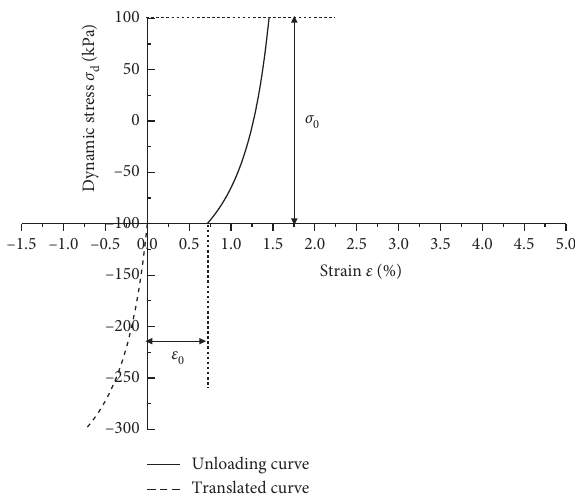
Figure 3: Stress-strain and translated stress-strain curves in the unloading stage.